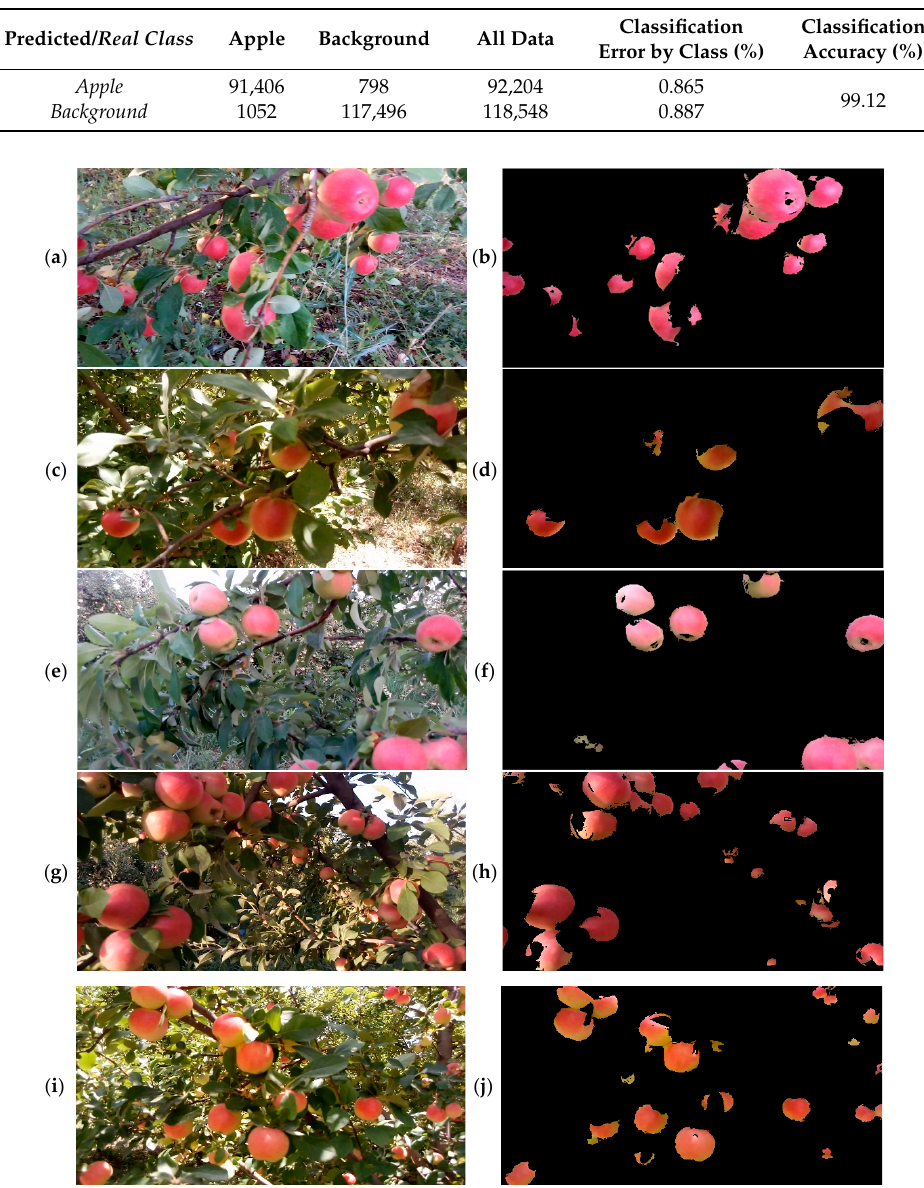
Table 7. Confusion matrix and accuracy of the proposed apple segmentation algorithm in the test set.